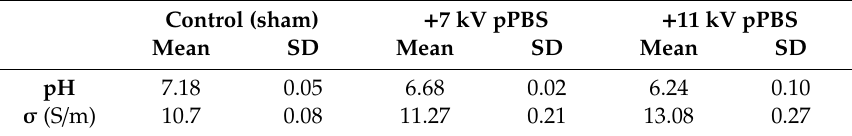
Table 1. pH and conductivity ( σ ) of the control (sham) and the pPBS at + 7 kV and + 11 kV for a PBS + / + treatment time of 20 min. Data are presented as mean values ± SD of independent quadruplicates.